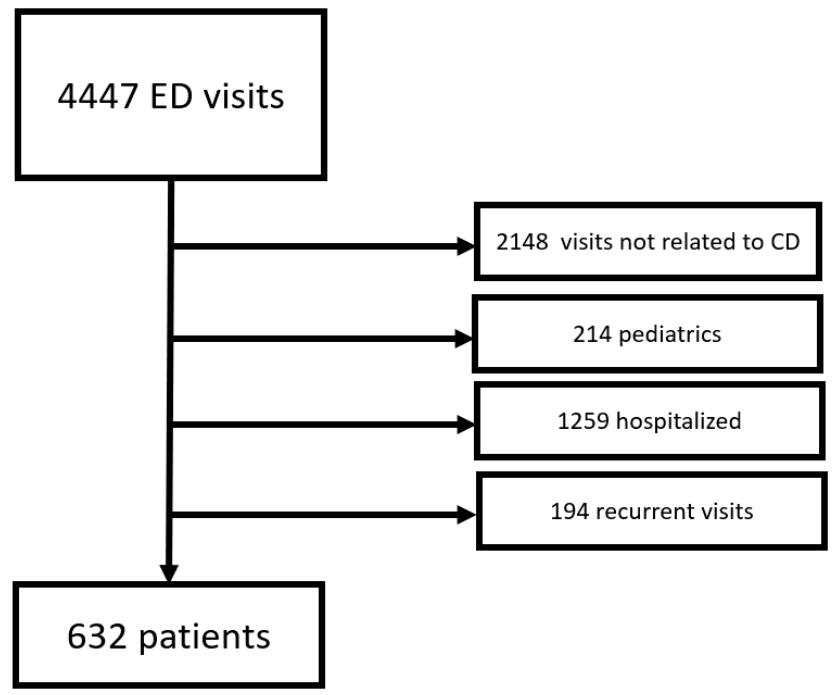
Figure 1. Flow chart showing the screened, included and excluded patients.